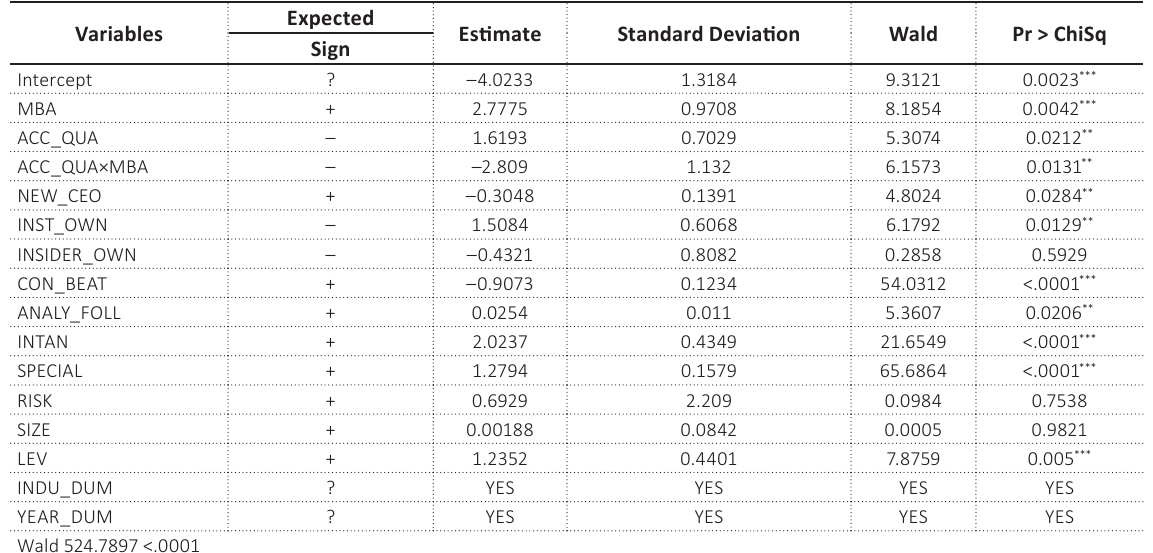
Table 6. The moderating effect of audit committee quality on the relationship between MBA-holding CEOs and non-GAAP earnings